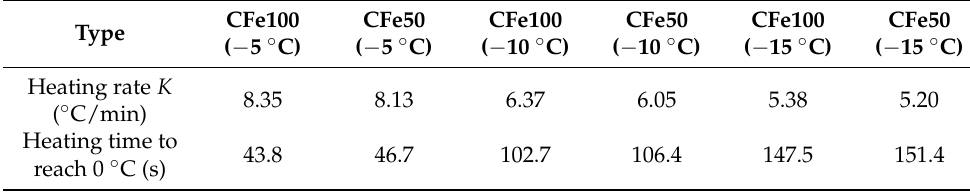
Table 5. The heating rate within 0–2 min and the heating time to reach 0 ◦ C.